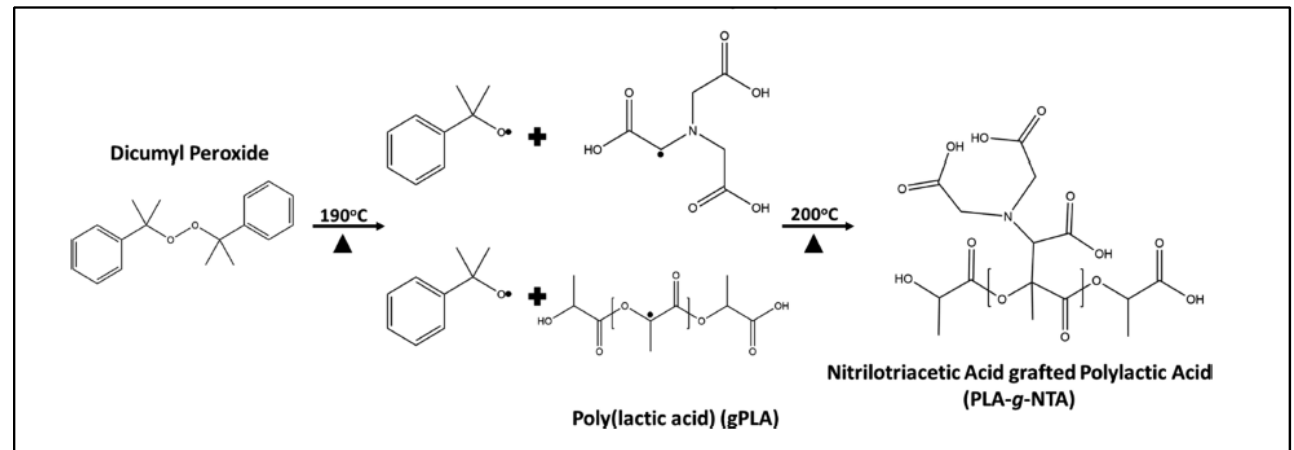
Figure 19. Reaction scheme for the grafting of NTA on PLA (from Herskovitz et al. [96], copyright American Chemical Society, reproduced with permission).